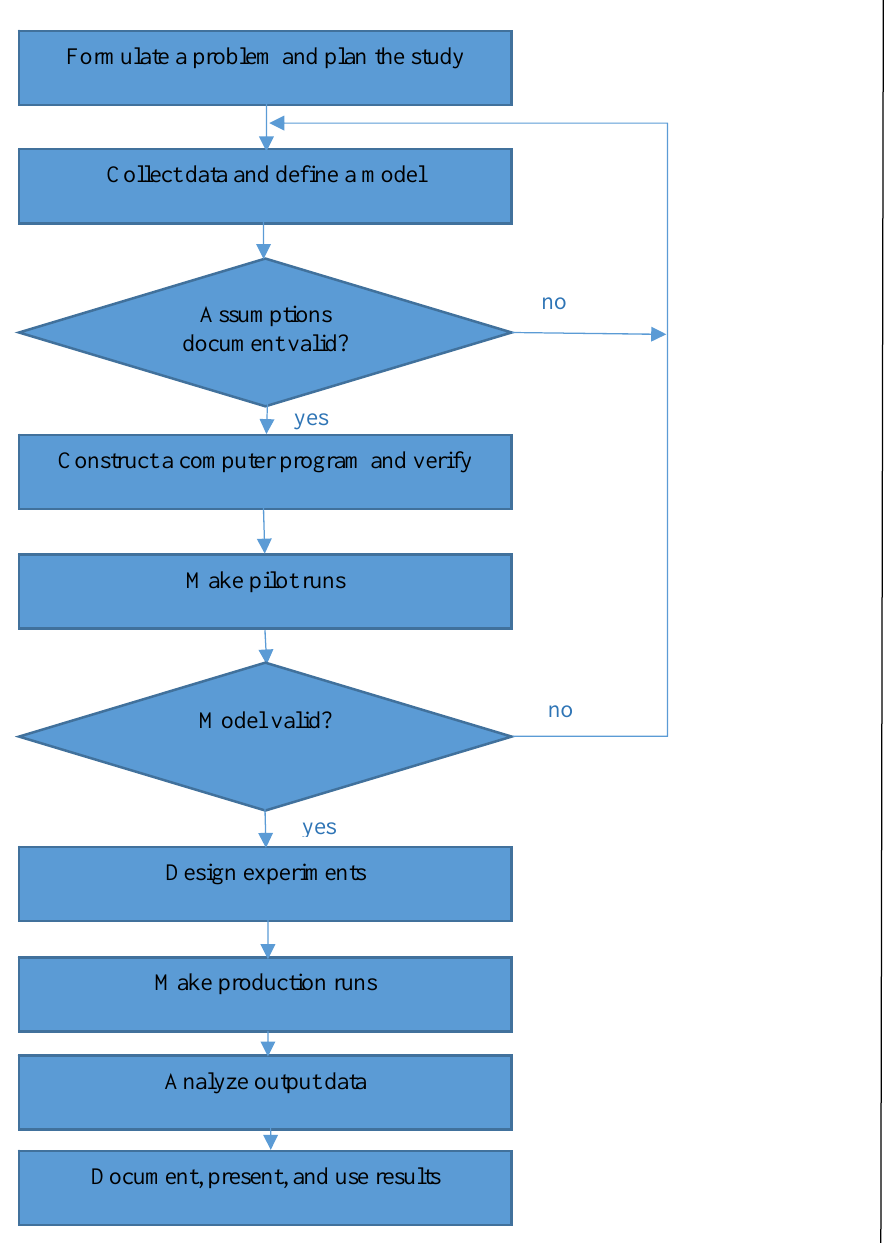
Figure 1 – Steps of modeling and a simulation of a model (Law, 2015) Рис . 1 – Шаги в моделировании и симуляции модели (Law, 2015) Слика 1 – Кораци у моделирању и симулацији модела (Law,